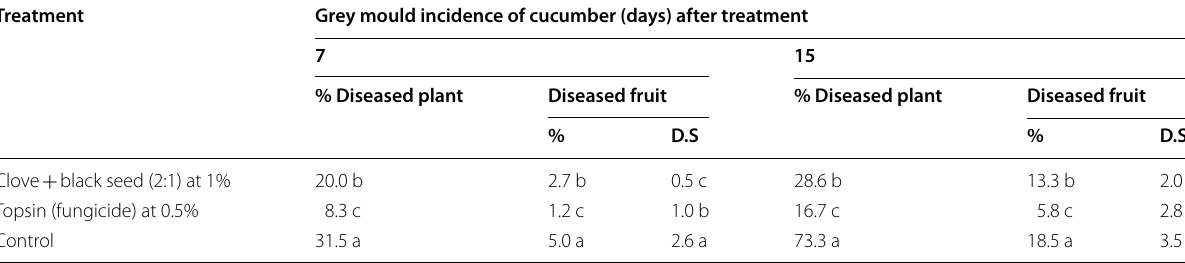
D. S disease severity: 0 = Values in each column followed by the same letter are not significantly different at P